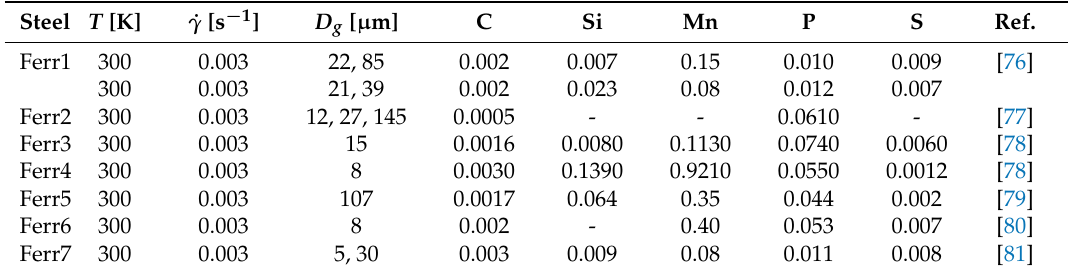
Table 3. Parameters and chemical compositions (in wt%) of ferritic steels.